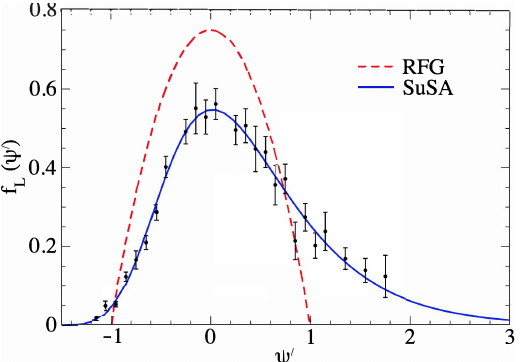
Figure 2. The RFG and SuSA scaling functions compared with the world averaged longitudinal inclusive electron scattering data